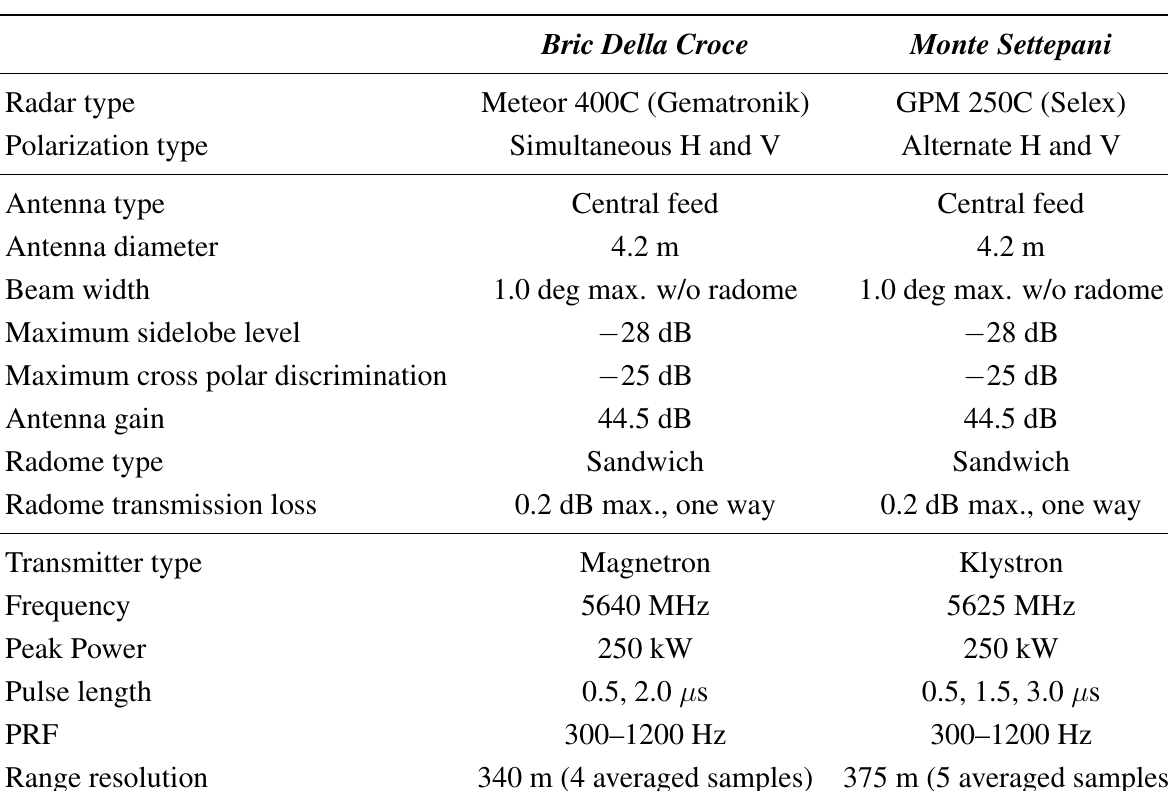
Table 1. Bric della Croce and Monte Settepani radar system